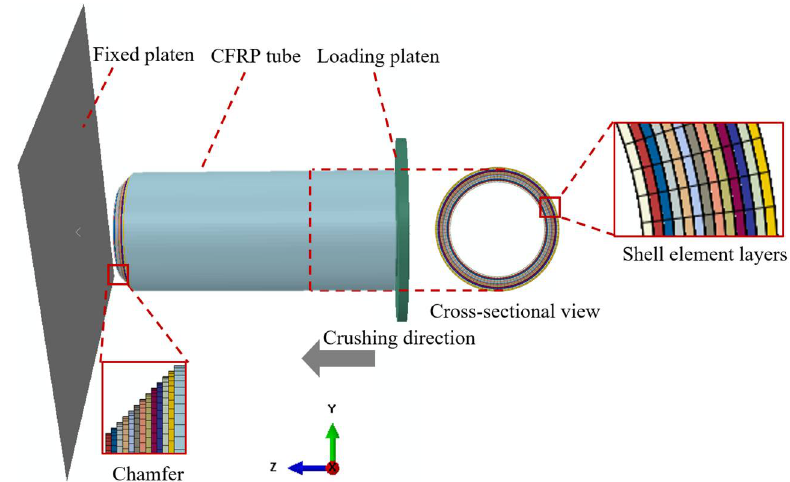
Figure 6. Numerical model of the axially crushing model.